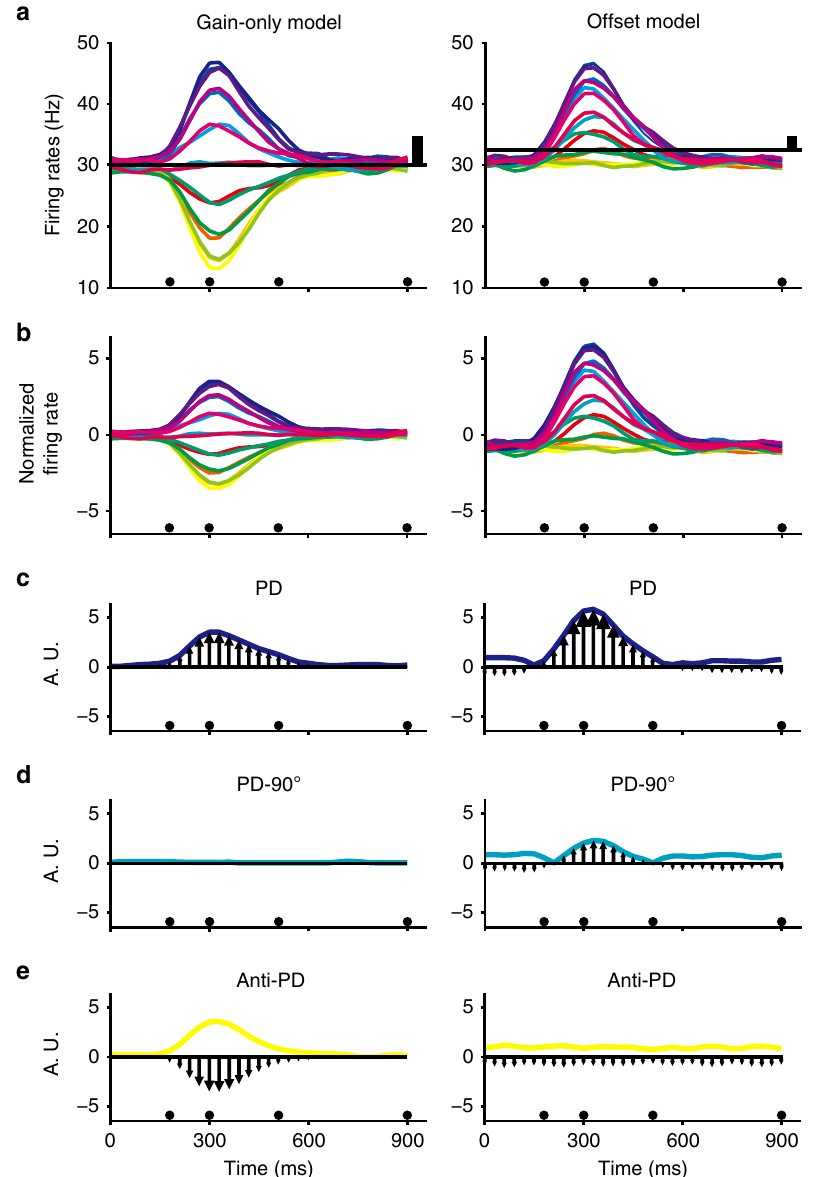
Fig. 4 The use of a conventional direction-only encoding model when fi ring rates were generated with either the gain-only (left column) or offset model (right column). a Simulated fi ring rates for one neuron and 16 target directions (same color map as in Fig. 1). The horizontal black lines represent estimated baseline, vertical black lines represent estimated modulation depth. b Firing rates normalized by estimated baseline and modulation depth using Eq. (10). c Vector magnitudes pointing to the preferred direction θ PD (arrows), the colored traces represent the absolute magnitudes. d Same as c for the orthogonal direction to θ PD , ( θ PD - 90°). e Same as c in the anti-preferred direction ( θ PD -180°). A.U.: arbitrary